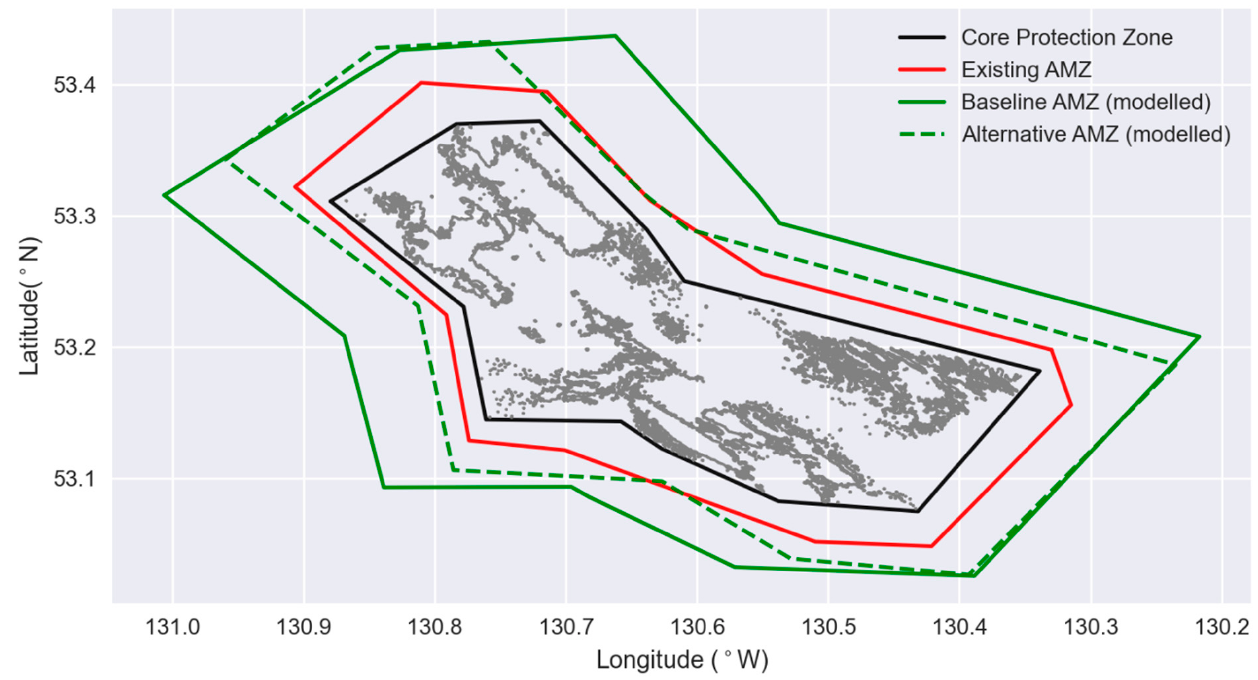
Figure 9. Map of the northern reef, CPZ, existing AMZ, new baseline AMZ, and new alternative AMZ. Table 3. Comparison of CPZ and AMZ areas (square kilometres) for the northern (N) reef. Region CPZ Existing AMZ Baseline AMZ Alternative AMZ N 524 791